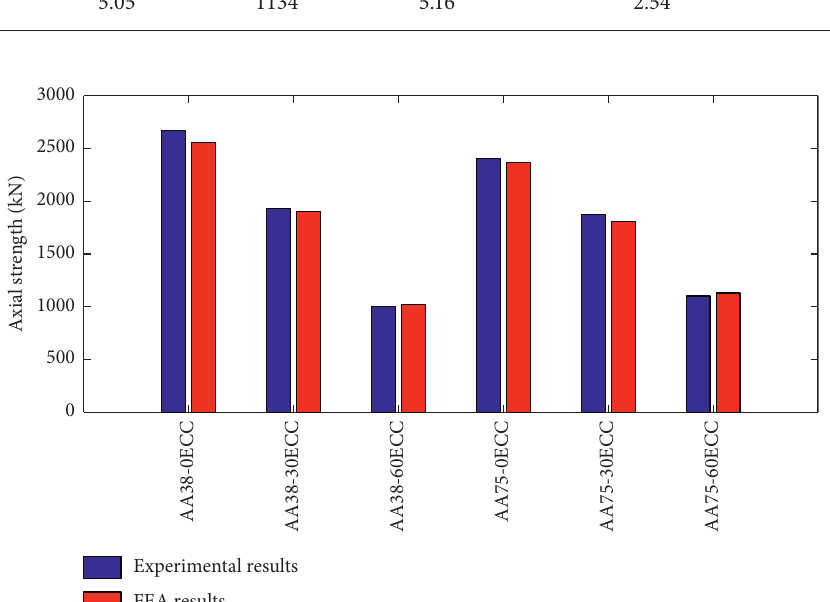
Figure 10: Comparison of experimental and FEA results for the peak AS of